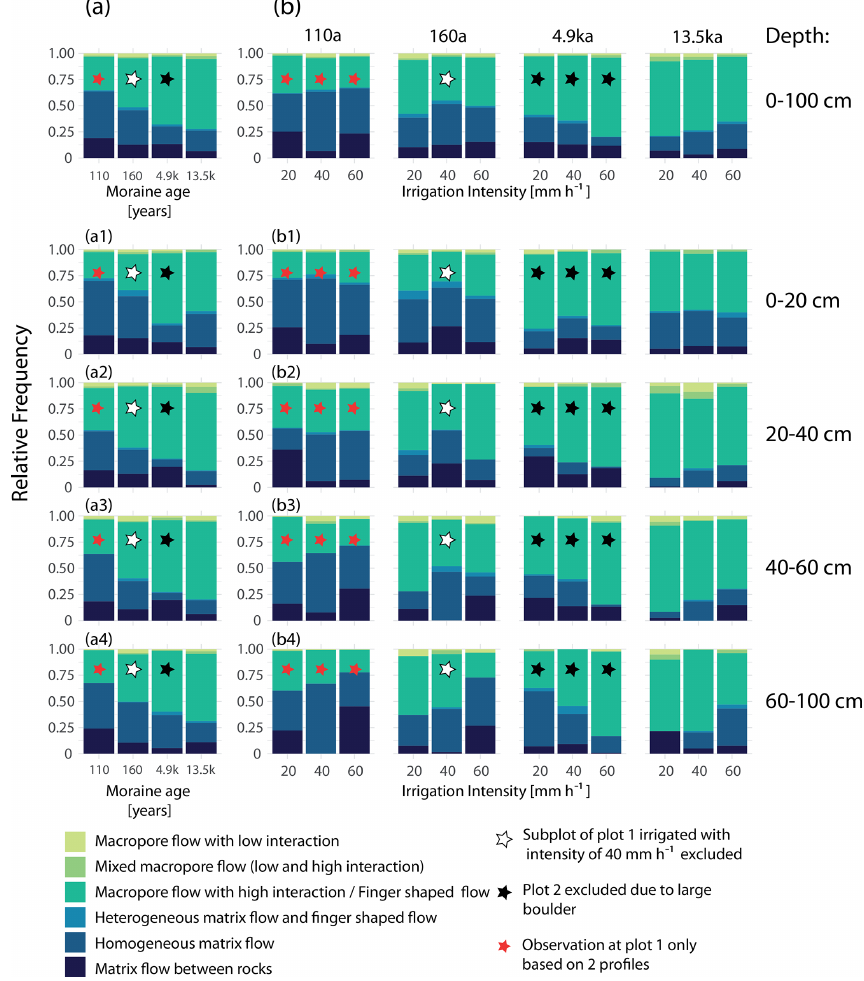
Figure 10. Relative frequency distribution of flow types (a) for the four moraine age classes, and (b) differentiated by irrigation intensity for each moraine age. The flow type frequency distribution is displayed once for the entire profile depth of 100cm (a, b) and once differentiated by four depth segments (a1–a4 , b1–b4) . Matrix flow types are displayed in a blue color scale and preferential flow types in a green color scale. A list of the relative frequencies of flow type occurrence can be found in Tables A1 and A2 in the